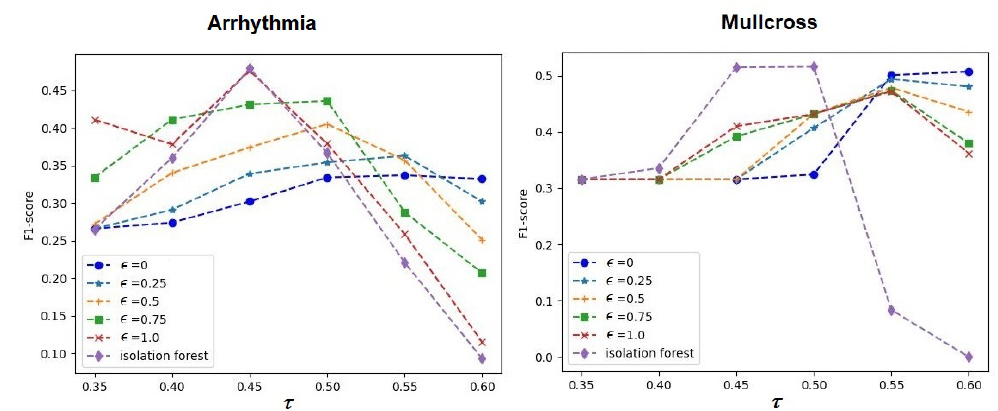
Figure 12. Comparison of iForest and ABIForest with different thresholds τ and with different con- tamination parameters (cid:101) for the Arrhythmia (the left panel) and Mullcross (the right panel) datasets.